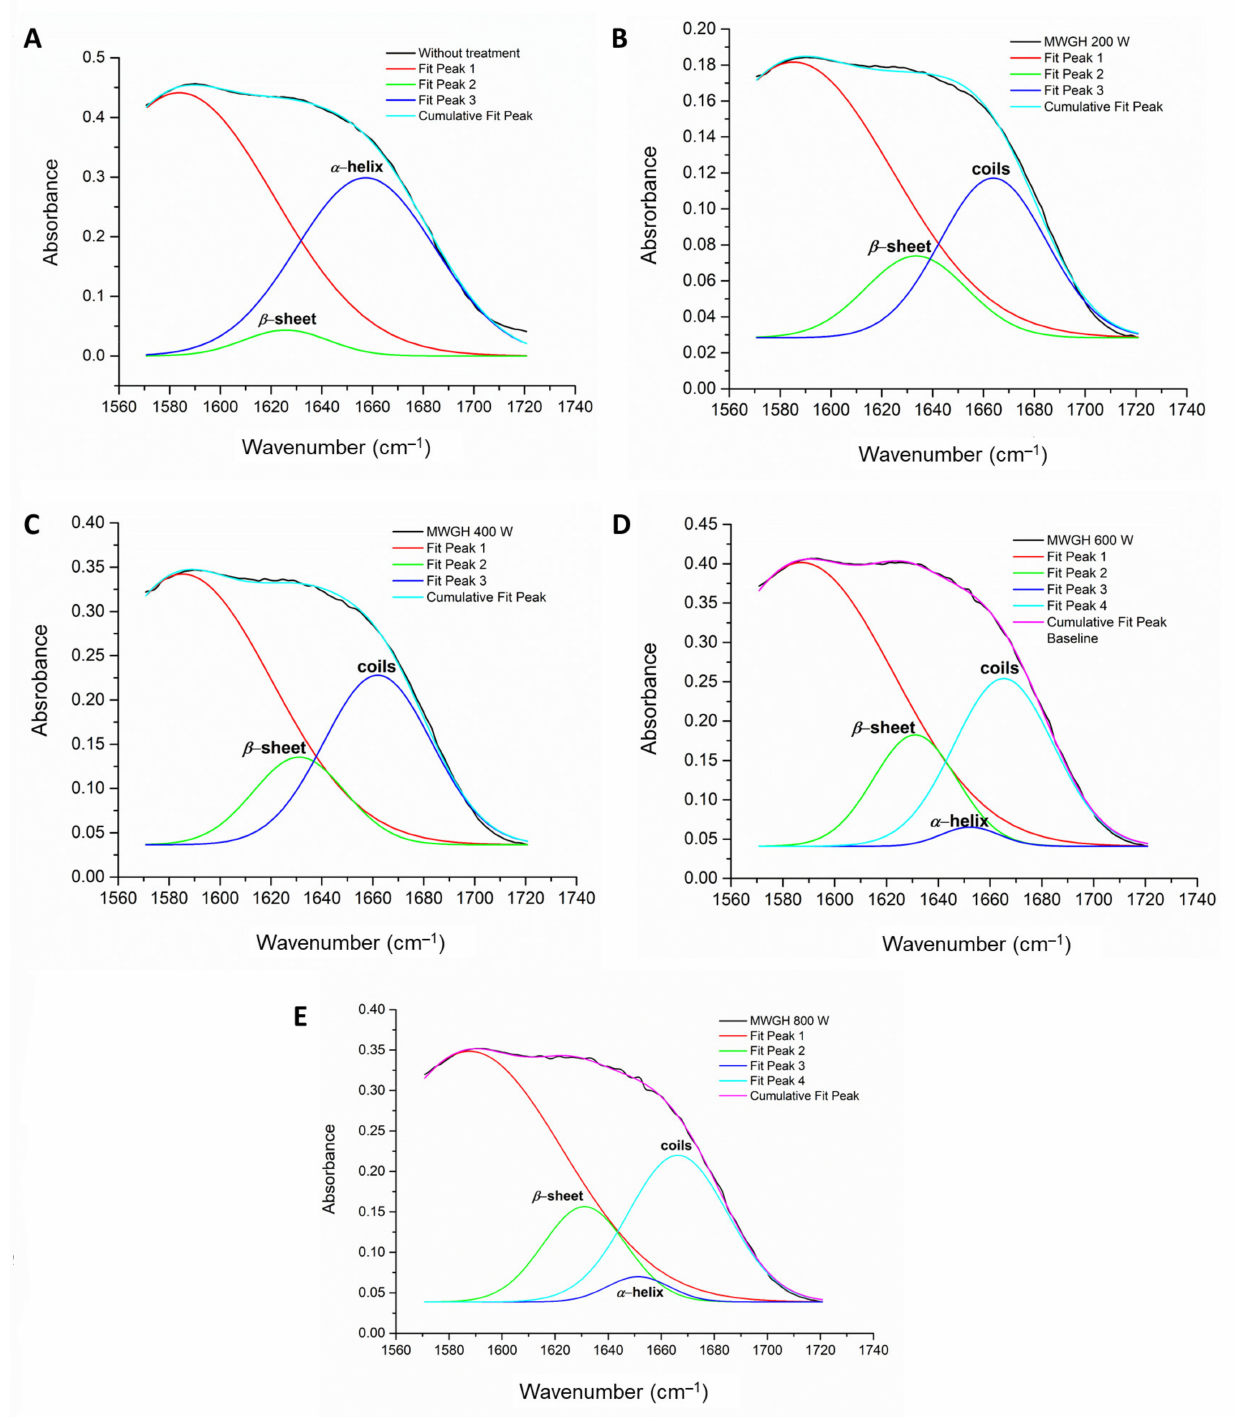
Figure 5. Peak deconvolution of Amide I band in the FTIR spectra of hydrolysates of gluten proteins ( A ) without pretreat- ment and microwave pretreated at powers of ( B ) 200 W, ( C ) 400 W, ( D ) 600 W and ( E ) 800 W using Peak and Baseline functions (baseline subtracting, deconvolution, second derivate and Gaussian fitting mode) in the OriginPro Lab